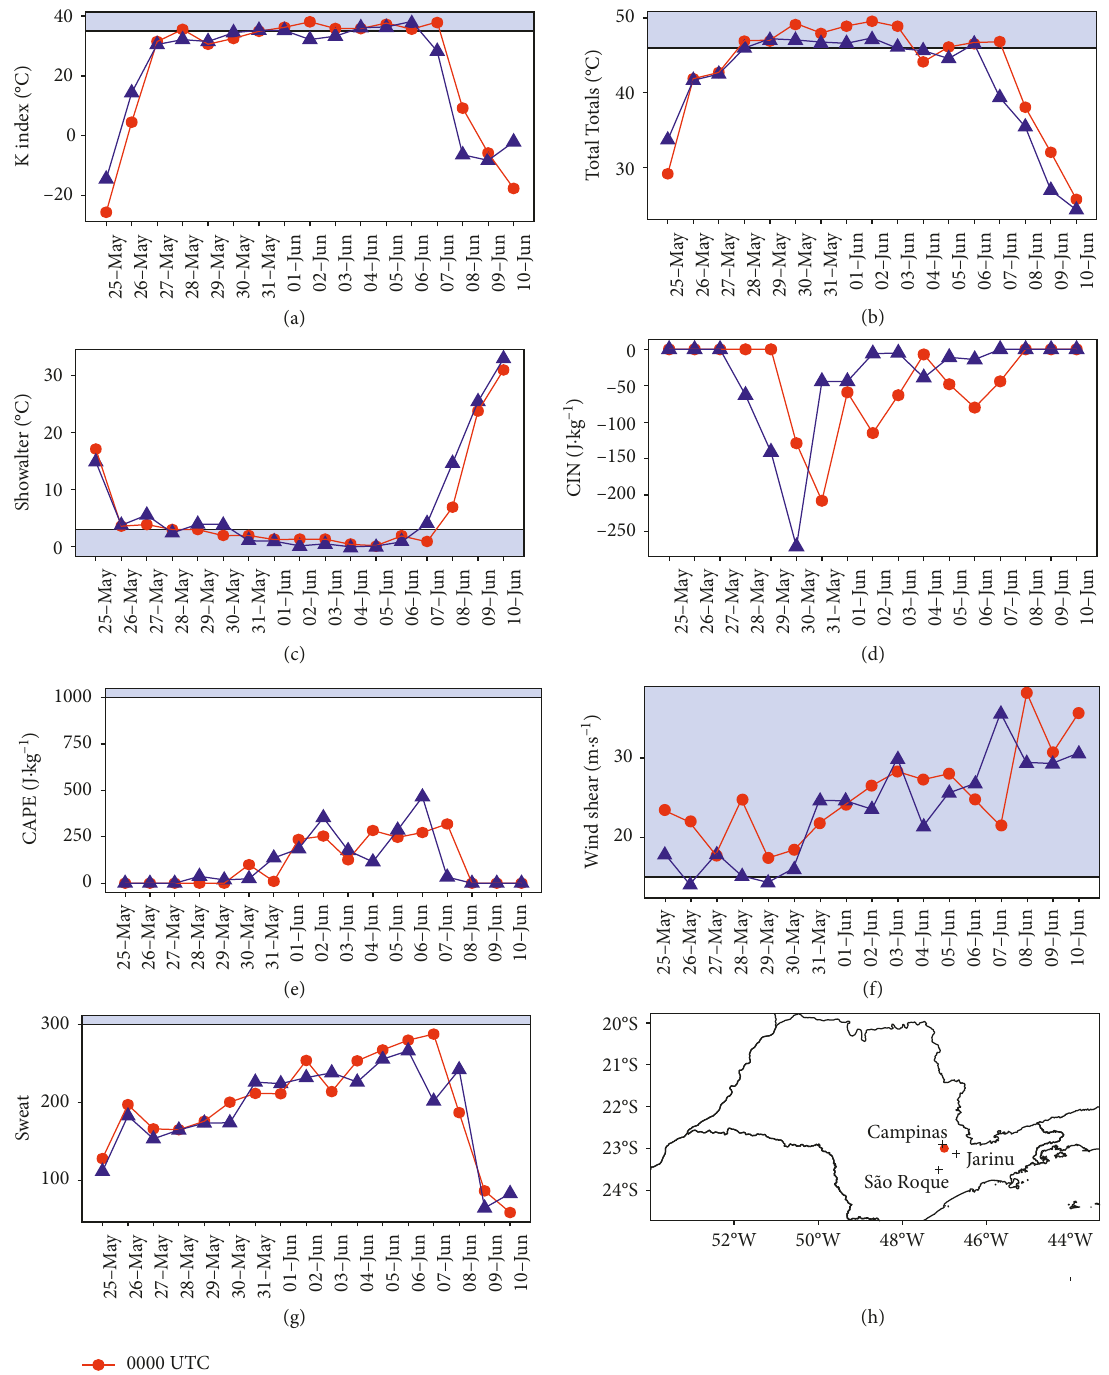
Figure 7: Temporal evolution of the instability indices at 0000 UTC (red) and 1200 UTC (blue): (a) K index ( ° C), (b) Total Totals ( ° C), (c) Showalter index ( ° C), (d) CAPE (J the location of where these indices were calculated (red dot) and the three cities where the most severe thunderstorms occurred (black crosses). The shaded areas from (a) to (g) indicate the values for